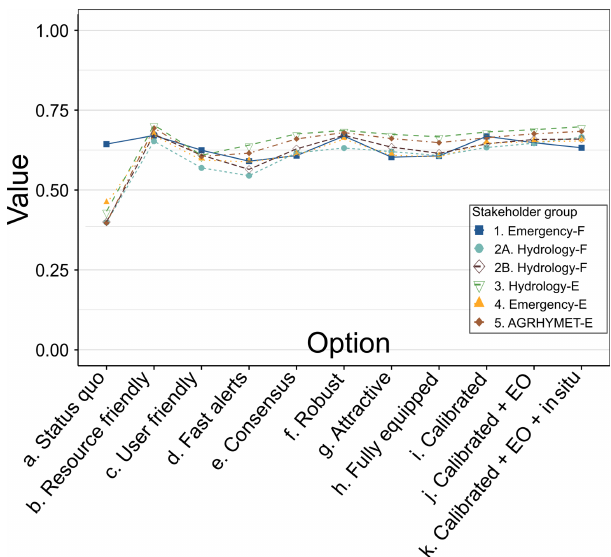
Figure 5. Total aggregated value ( y axis) of 11 FEWS configura- tions ( x axis) for six stakeholder groups (symbols), without uncer- tainty. Higher values indicate that they better achieved the objec- tives, given expert predictions and stakeholders’ preferences.